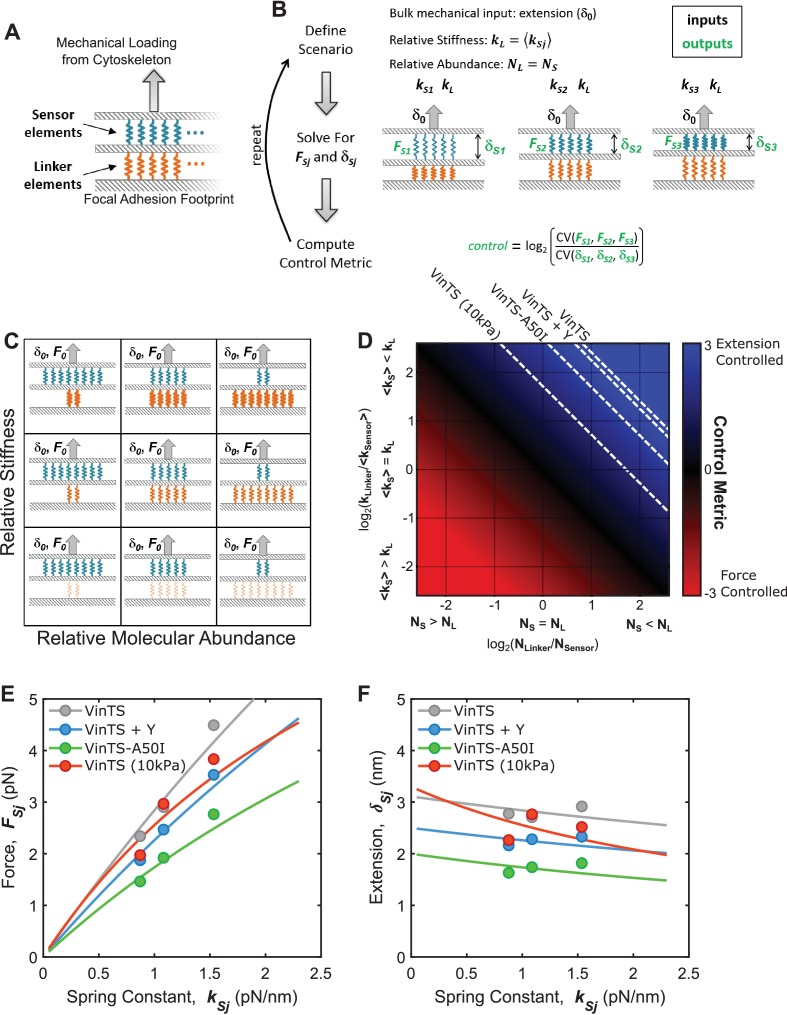
Various structural arrangements within FAs could lead to force-based or extension-based control.(A) FA structural model consists of two parallel layers of proteins, which can be conceptualized as either ‘sensor’ (blue) or ‘linker’ (orange) elements. (B) Mimicking what was done in experiments (Figure 4), simulations involved three sensor elements with distinct stiffnesses (kS1, kS2, kS3), arranged in a stratified fashion with a single linker element (stiffness kL), loaded by a bulk extension (or force) input. The forces and the extensions experienced by each sensor element were calculated, and a Control Metric relating the relative variation in forces to the variation in extensions was calculated (see Appendix 2 for details). (C) Schematic depiction of parameter space examined using this simple structural model of FAs, wherein the relative number of the sensor and linker element is varied (x-axis) along with their relative stiffness (y-axis); thicker springs indicate stiffer mechanics. (D) Summary of results from simulations quantifying force-controlled versus extension-controlled loading of the sensor element. Control Metric describes the ratio of variation in forces to the variation in extensions experienced by the sensor elements and will be positive for extension-controlled situations and negative for force-controlled situations. Following a bulk extension input, force-controlled loading of the sensor element occurs when the sensor element is stiff and in relatively high abundance, while extension-controlled loading of the sensor element occurs when the sensor element is soft and/or in relatively low abundance. Dashed contour lines are depicted that correspond to the measured Control Metric for VinTS, VinTS + Y-27632, VinTS-A50I, and VinTS on 10 kPa gels (Control Metric=3.2, 3.1, 2.6, 1.7, respectively). (E-F) FA structural model predictions of the relationship between sensor element stiffness (spring constant) and force (E) or extension (F). Dashed contour lines in panel (D) correspond to force-stiffness relationships in (E) and extension-stiffness relationships in (F).